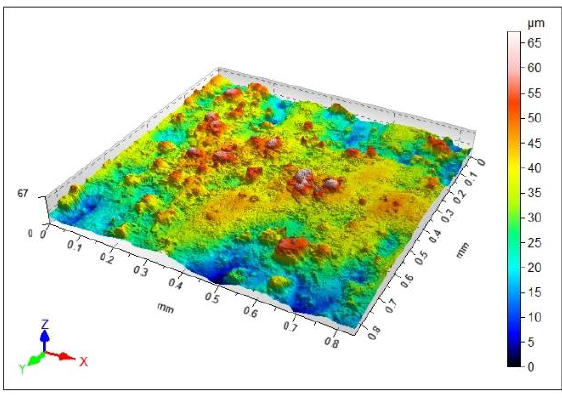
Figure 9. Surface texture measured on the rake face.